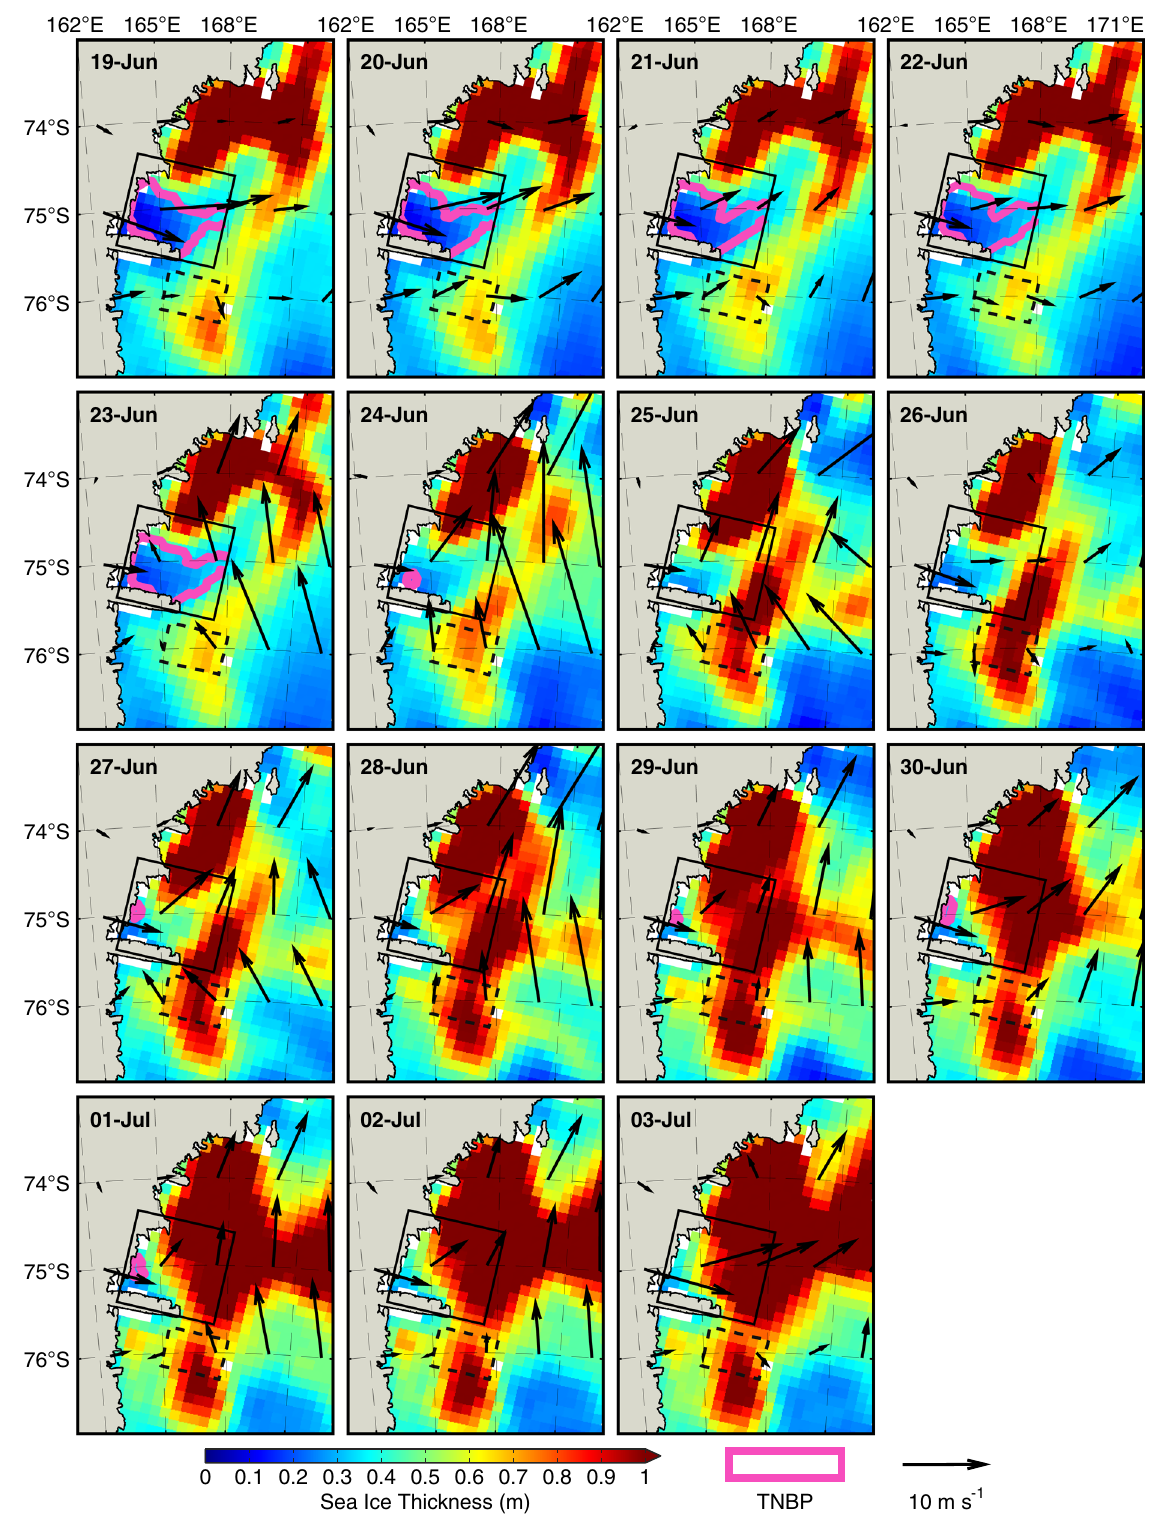
Fig. 3 The sea ice thickness surrounding the TNBP from 19 June to 03 July, 2013. The color map responds to the sea ice thickness with the land mask from NASA ’ s MOD44W (in white pixels). The vector shows the daily mean winds from ERA-5 data. The black box is the TNBP study area, and the black dashed box is where we obtain the TCI thickness. In the red dashed area, the edge of the TNBP is marked with a magenta line. The grey land mask is from the GSHHG coastline as in Fig.